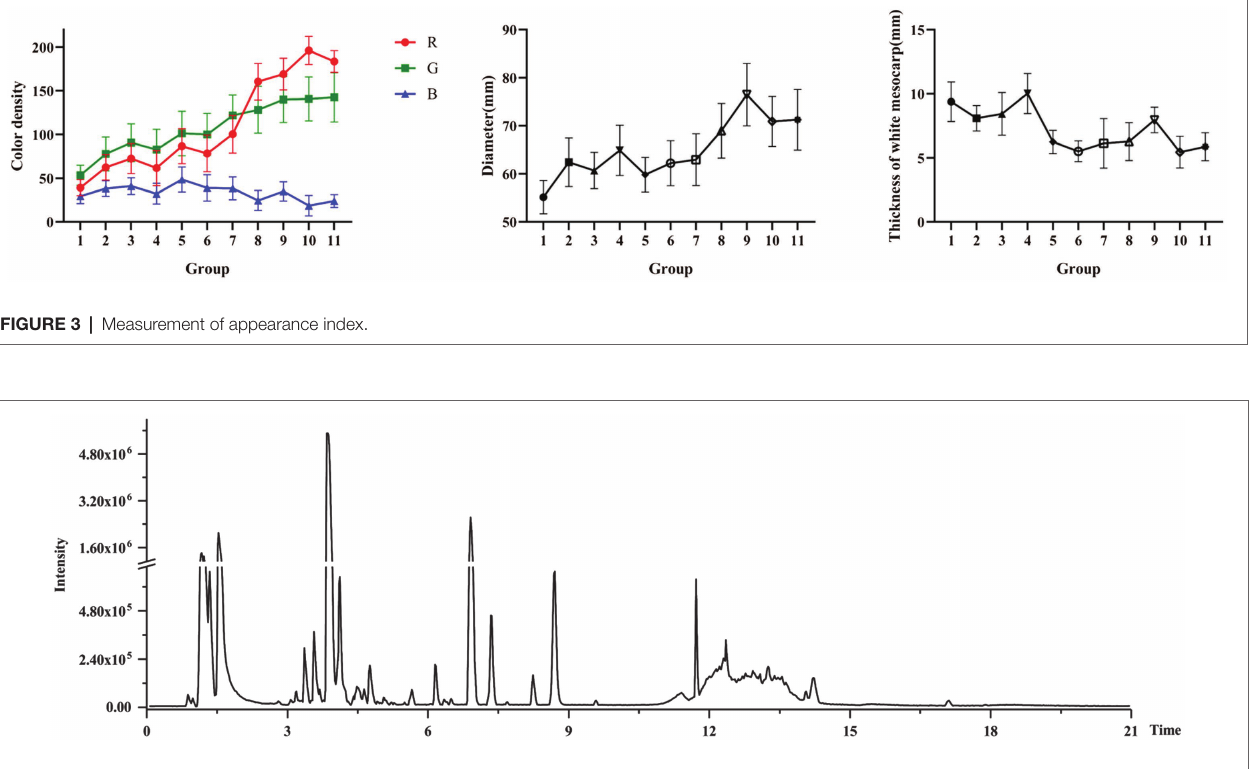
FIGURE 4 | Representative total ion chromatogram.